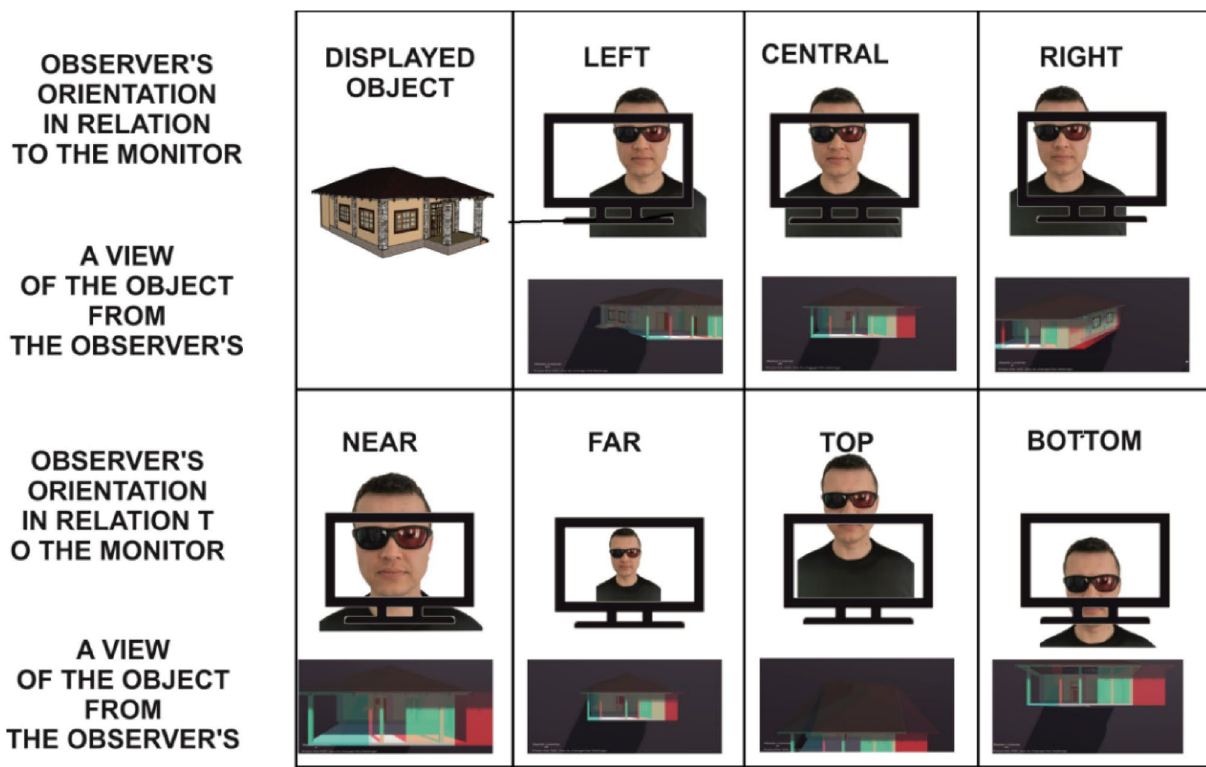
Figure 5. Diagram of Holo-SDK operation from the observer’s perspective. Source own